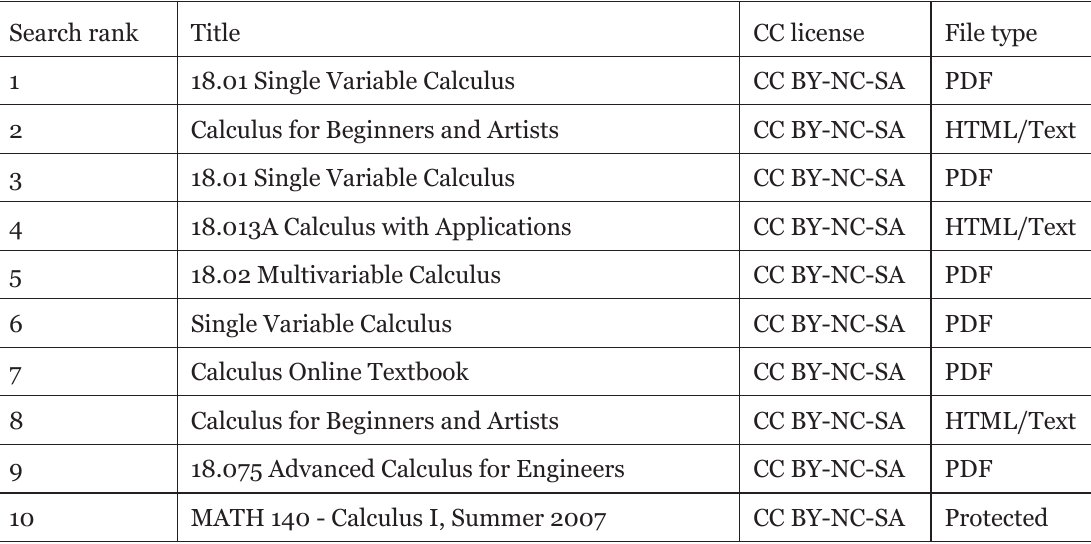
Top Ten Search Results Returned by MERLOT for the Keyword Calculus Search rank